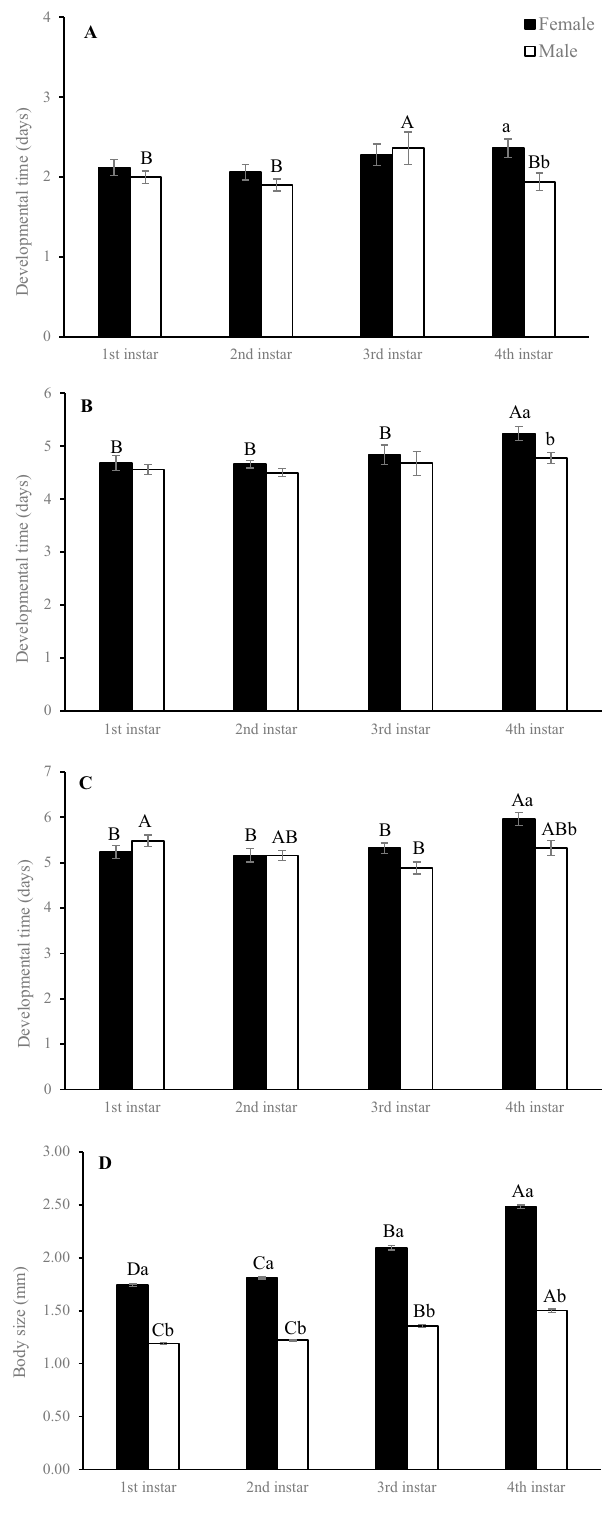
Figure 2. Mean developmental time (mean ± SE) of the egg stage ( A ), larval stage ( B ), and pupal stage ( C ) and body size ( D ) of female and male Necremnus tutae offspring on different instars of Tuta absoluta larvae. Bars topped by different capital letters within the same sex indicate a significant difference between different host instars; the different lowercase letters indicate that there was a significant difference in the same instar between female and male T. absoluta hosts; no lettering indicates no significant